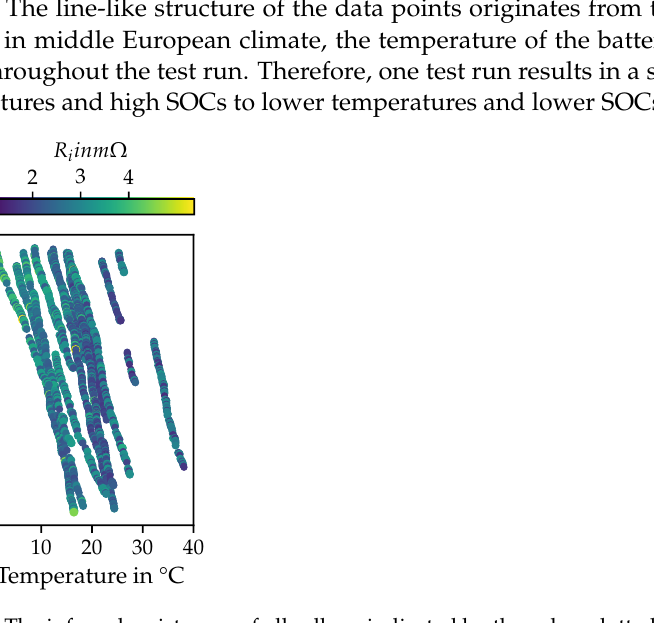
Figure 8. The inferred resistances of all cells as indicated by the color, plotted over the environmental variables SOC and temperature.